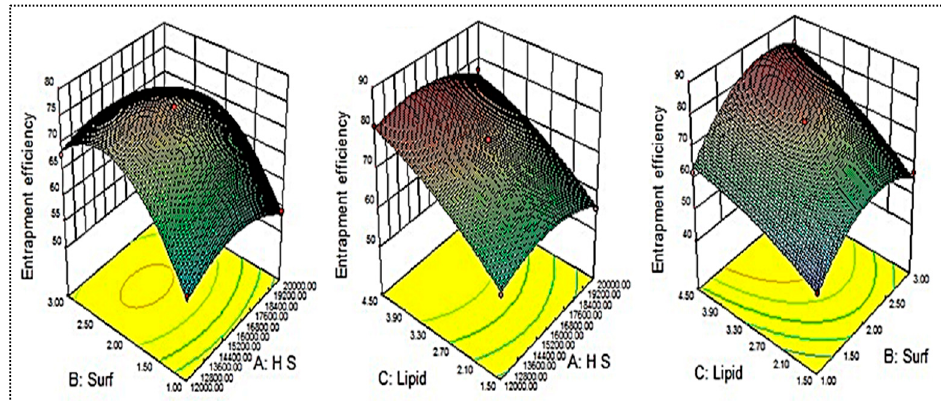
Figure 3. Effects of independent variables (Homogenization speed—A, Surfactant—B, Lipid—C) on the encapsulation efficiency (Y 2 ).